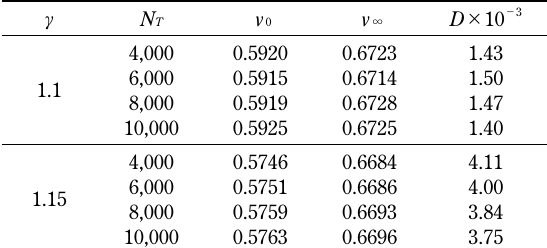
Table 4. Fitting parameters for reciprocal linear